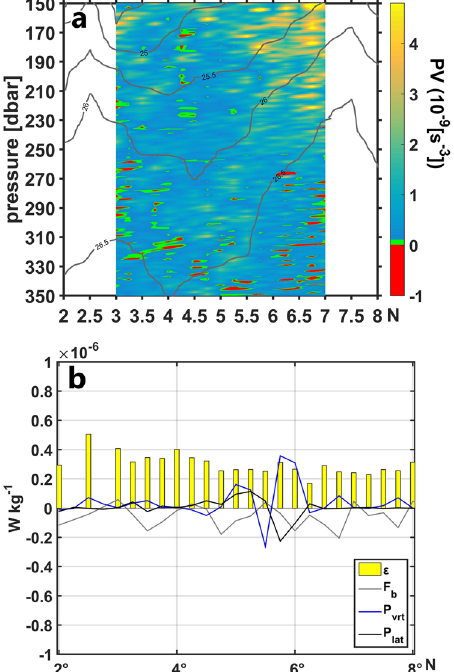
Fig. 3 Vertical pro fi le of potential vorticity (PV) and energy source estimation from observation. a The Latitude-depth section of PV (in s − 3 ) calculated from the MSP measurements between 150 and 350 m along the 130°E section between 2°N and 8°N. Areas of negative and zero pv are marked in red and green to indicate the overturning instabilities. b The 150 – 350 m vertically integrated turbulent kinetic energy dissipation rates, ε (yellow bars) and the turbulent kinetic energy production associated with gravitational instability ( F b , gray line), symmetric instability ( P vrt , blue line), and centrifugal instability ( P lat , black line). Unit is W kg − 1